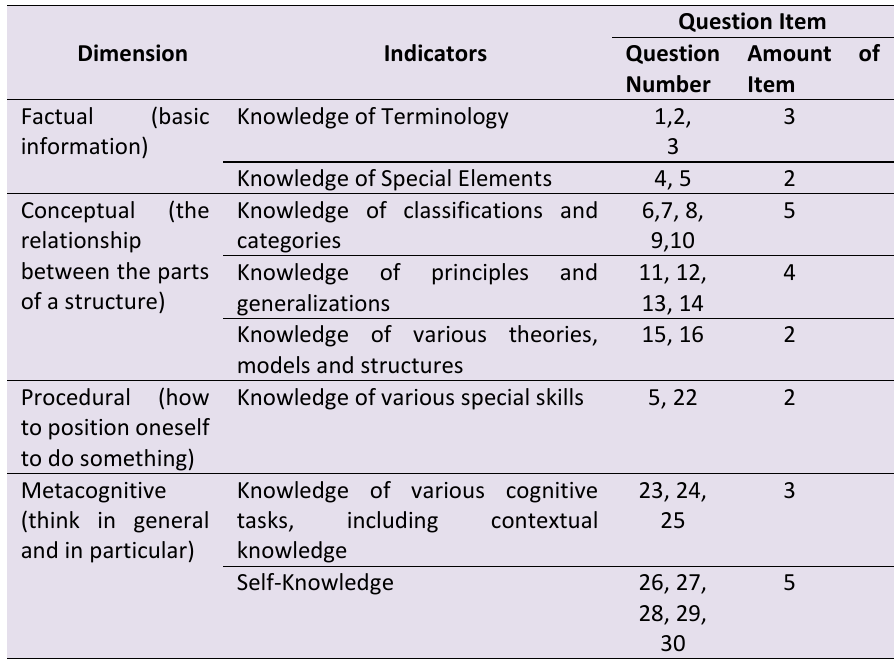
Table 2 . Instrument of Knowledge of Issue